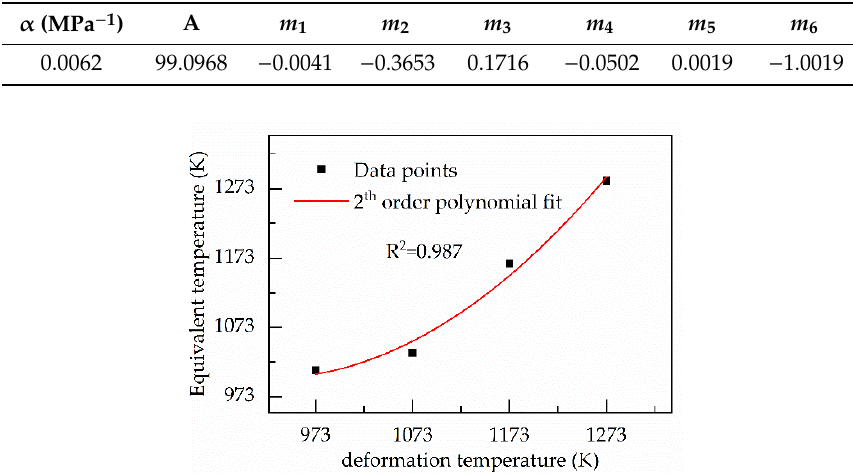
Figure 19. Relationship between the deformation temperatures and the equivalent temperatures in the mHS equation. Table 6. Coefficients of the polynomial for the equivalent temperatures in the mHS equation.